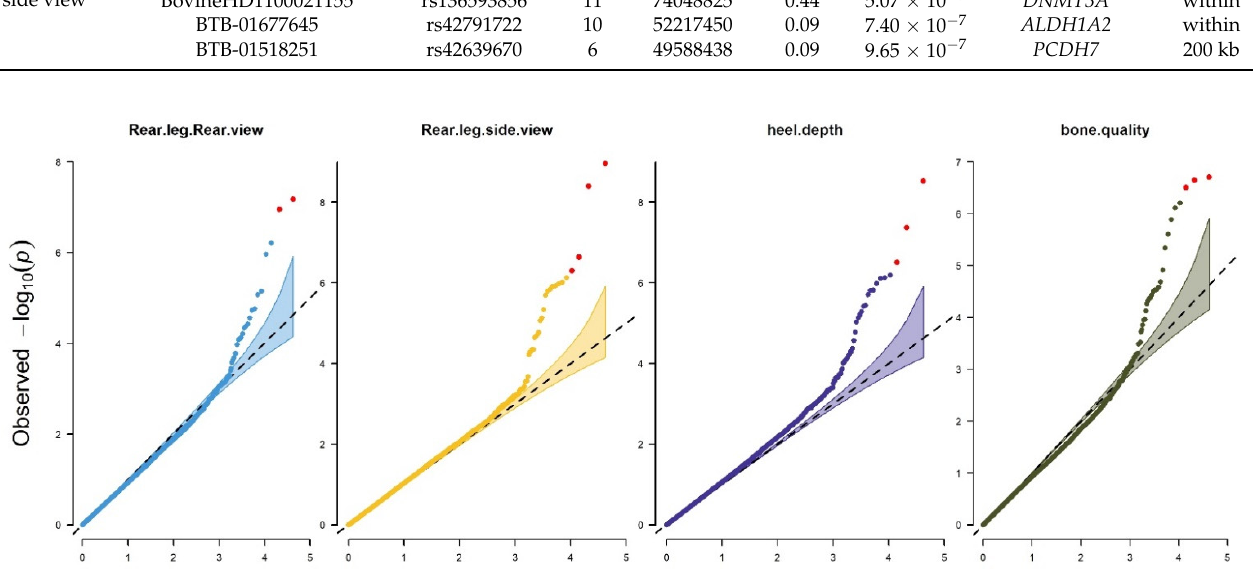
Rear legs side view